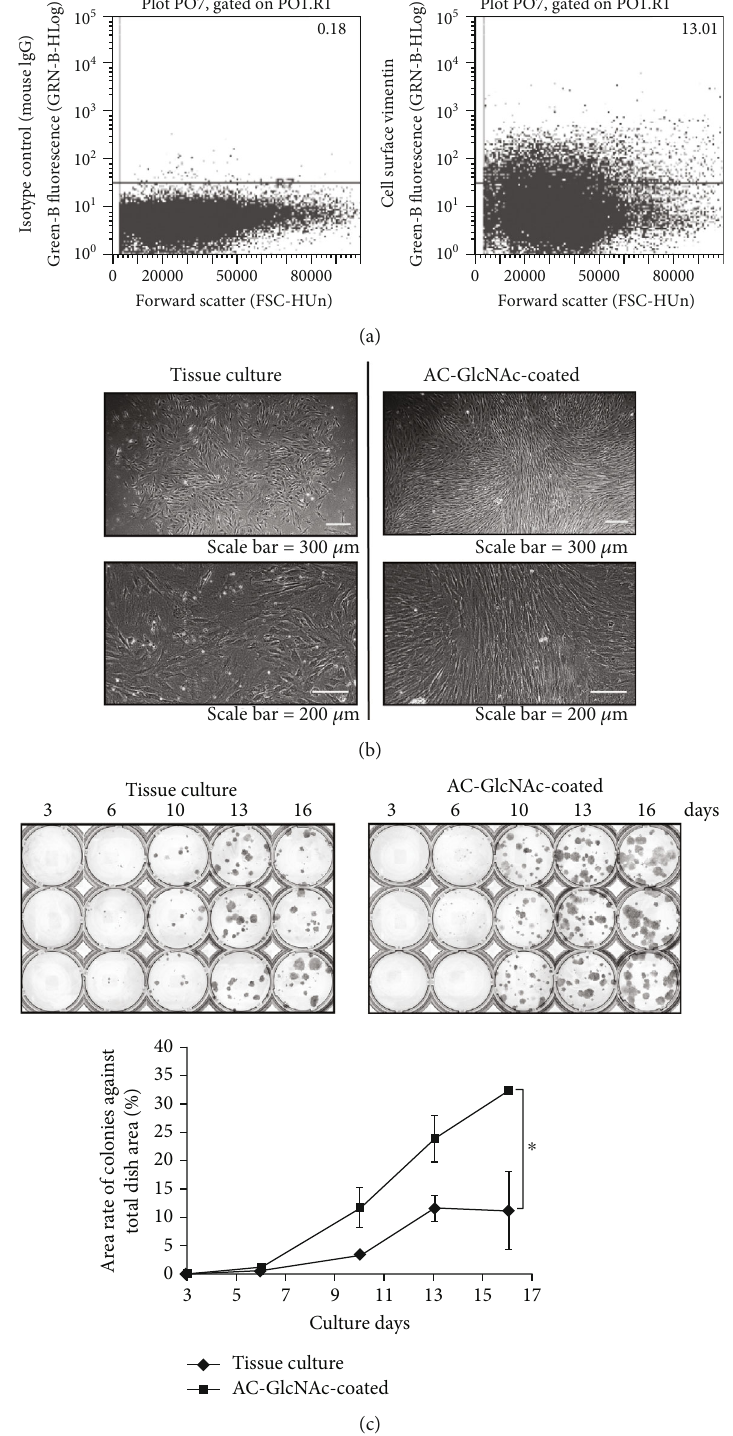
Figure 3: Characteristics of rat bone marrow cells grown on AC-GlcNAc-coated and uncoated tissue-culture dishes. (a) Flow cytometric analysis of expression of cell-surface vimentin in rat bone marrow cells. (b) Phase-contrast images of colonies formed on tissue-culture dishes and AC-GlcNAc-coated dishes at 10 days. Lower images are enlargements of upper images. (c) Images of crystal violet-stained colonies and areas of colonies over 3 to 16 days of culture. ∗ P < 0 : 01 , n = 3